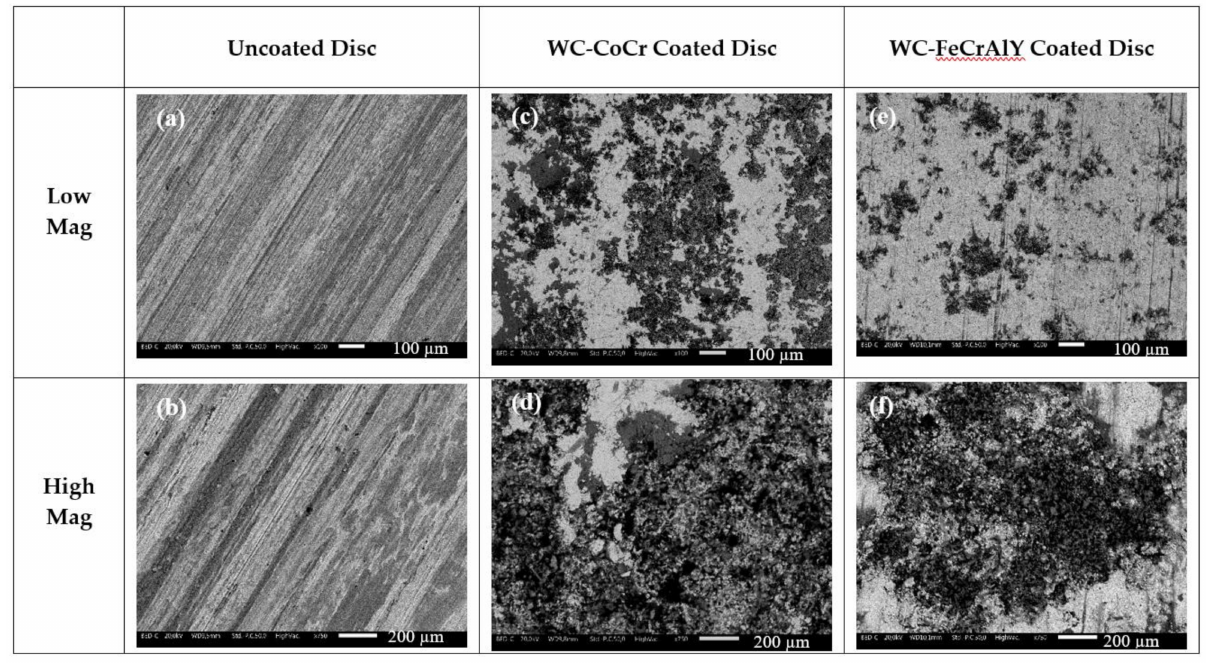
Figure 15. Worn top view at different magnifications of the counterface ( a , b ) the uncoated disc, ( c , d ) the WC-CoCr-coated disc, and ( e , f ), the WC-FeCrAlY-coated